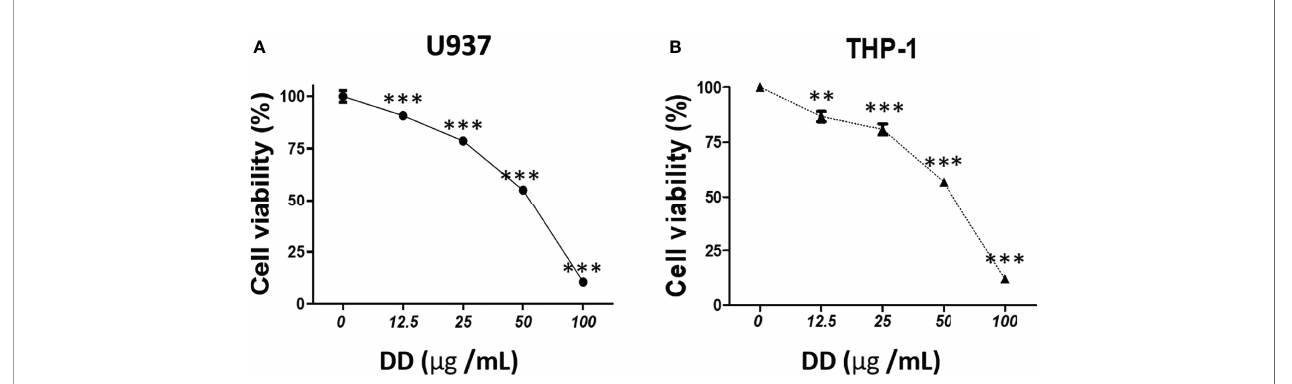
FIGURE 2 | Daemonorops draco Blume (DD) exerted a cytotoxic effect on acute myeloid leukemia cells. The cytotoxicity of DD in (A) U937 and (B) THP-1 cells. The cells were treated with DD (i.e., 12.5, 25, 50, 100, or 200 m g/ml) for 24 h. Cell viability assay was performed using EZ-Cytox. Values above represent the means of three experiments. Means ± standard deviation; ** p < 0.01 and *** p < 0.001 compared with the untreated groups.